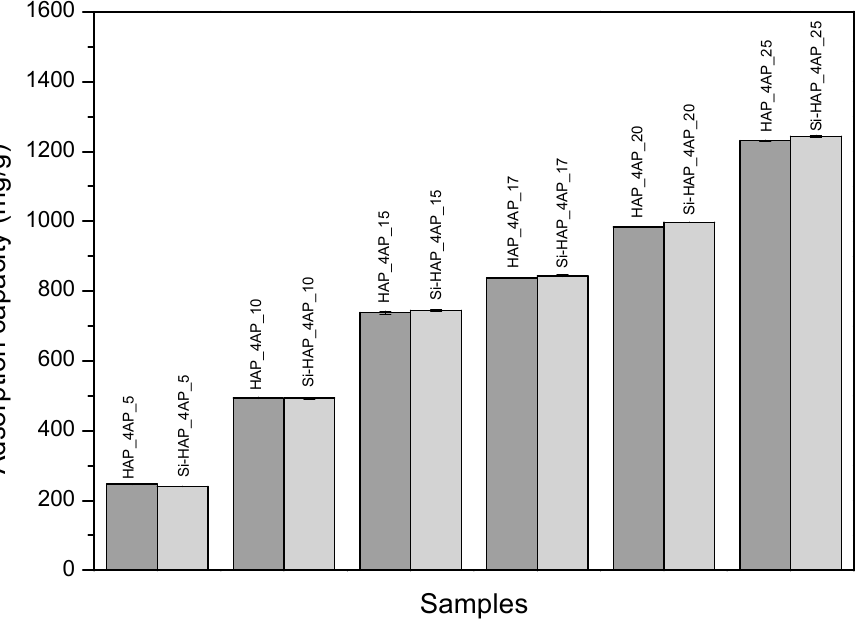
Figure 1. Adsorption capacity of 4AP ‐ loaded onto HAP (gray) and Si–HAP (light gray)